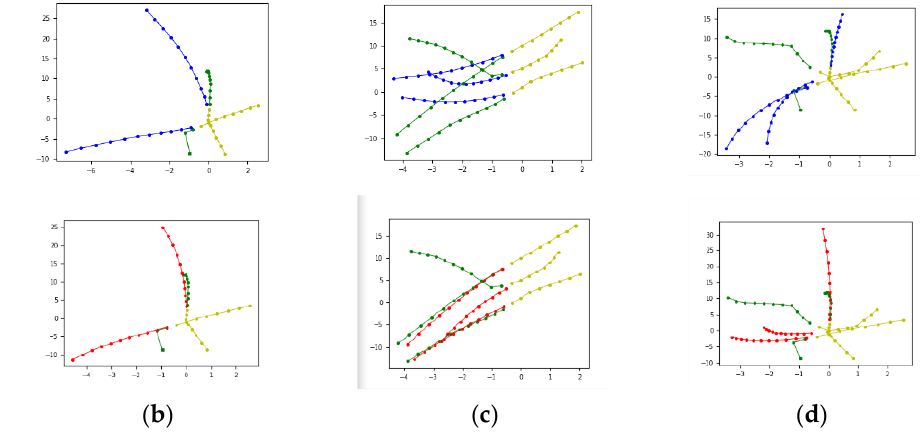
Figure 6. Trajectory visualization in different scenes. The yellow dot lines represent the observed trajectories, and the blue and red lines are the trajectories predicted by STAR [27] and our proposed model. The green lines are the ground truth. ( a ) Pedestrians walked in parallel from the same direction. ( b ) Pedestrians walked in perpendicular direction. ( c ) Multi pedestrians walked from the same direction. ( d ) Multi pedestrians walked from different direction.